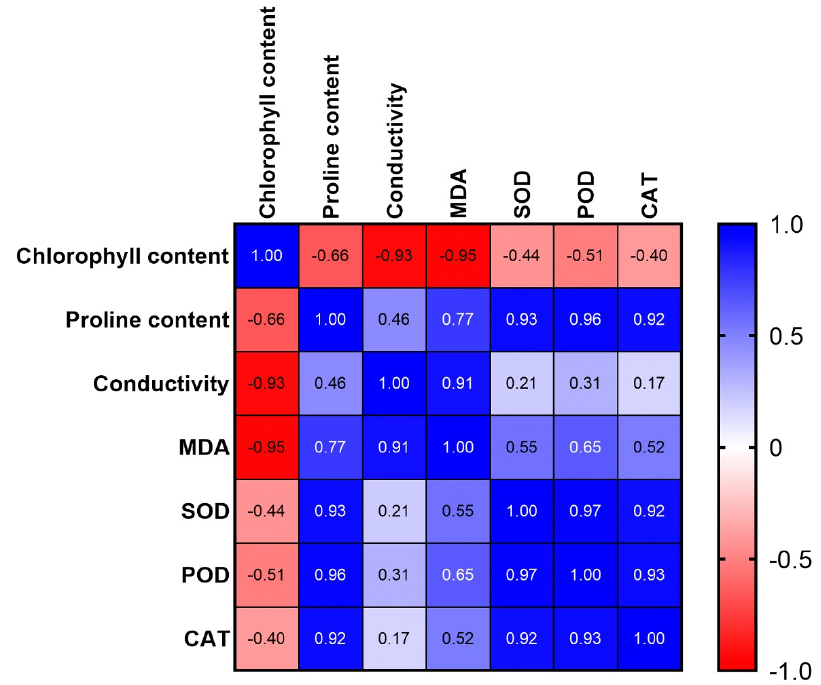
Figure 2. The correlation matrix for related physiological and biochemical indexes.